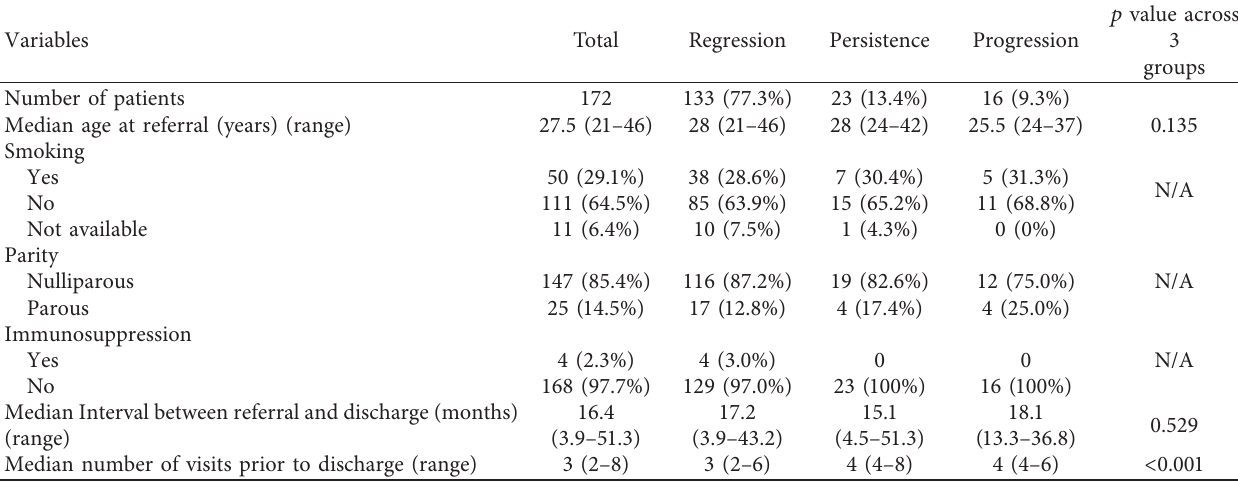
Table 2: Risk factors and other characteristics in initial conservative management